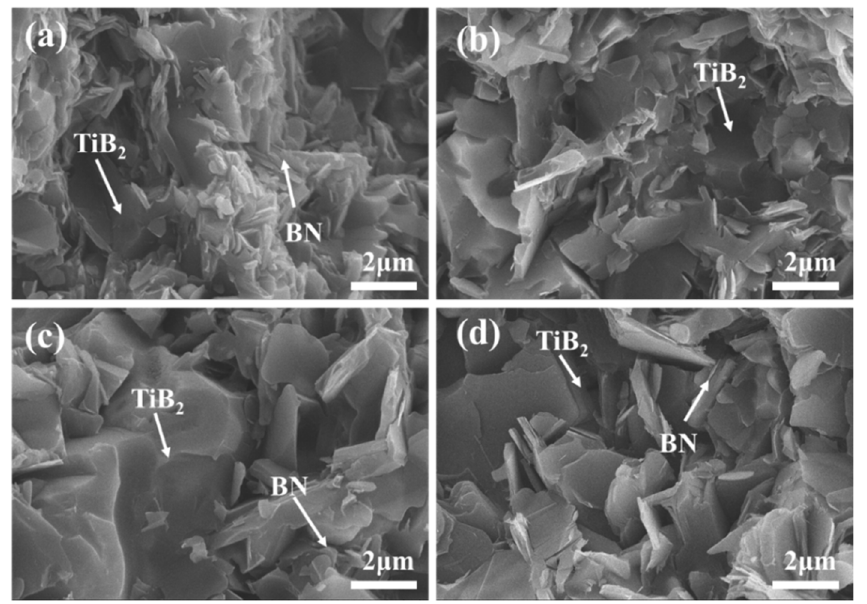
Figure 8. Cross-sectional SEM images of TiB 2 -BN-SiC composite ceramics at four sintering temper- atures: ( a ) 1650 °C, ( b ) 1750 °C, ( c ) 1850 °C, and ( d ) 1950 °C. tures: ( a ) 1650 ◦ C, ( b ) 1750 ◦ C, ( c ) 1850 ◦ C, and ( d ) 1950 ◦